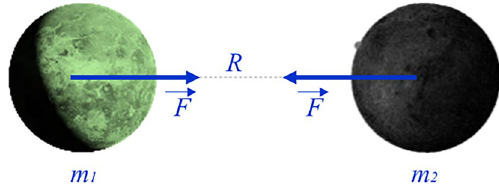
Figure 1. The force F acting between two planets.